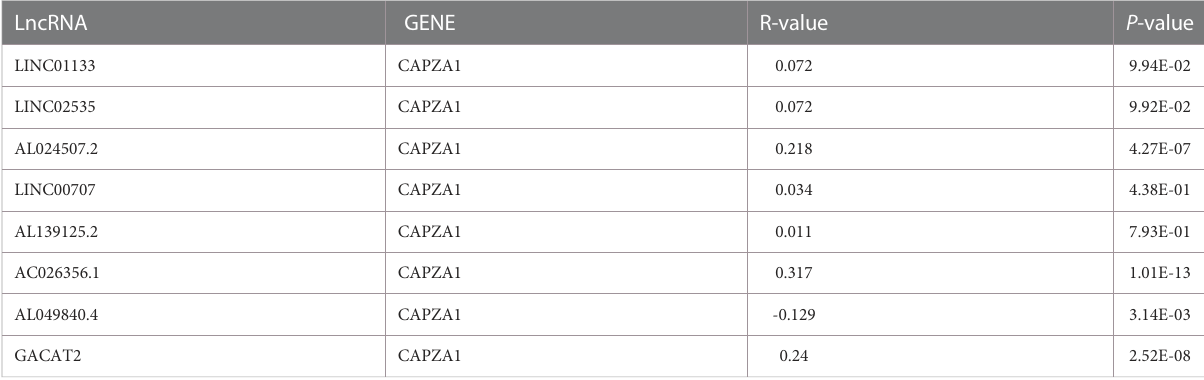
TABLE 2 The correlation between lncRNA and CAPZA1 in lung